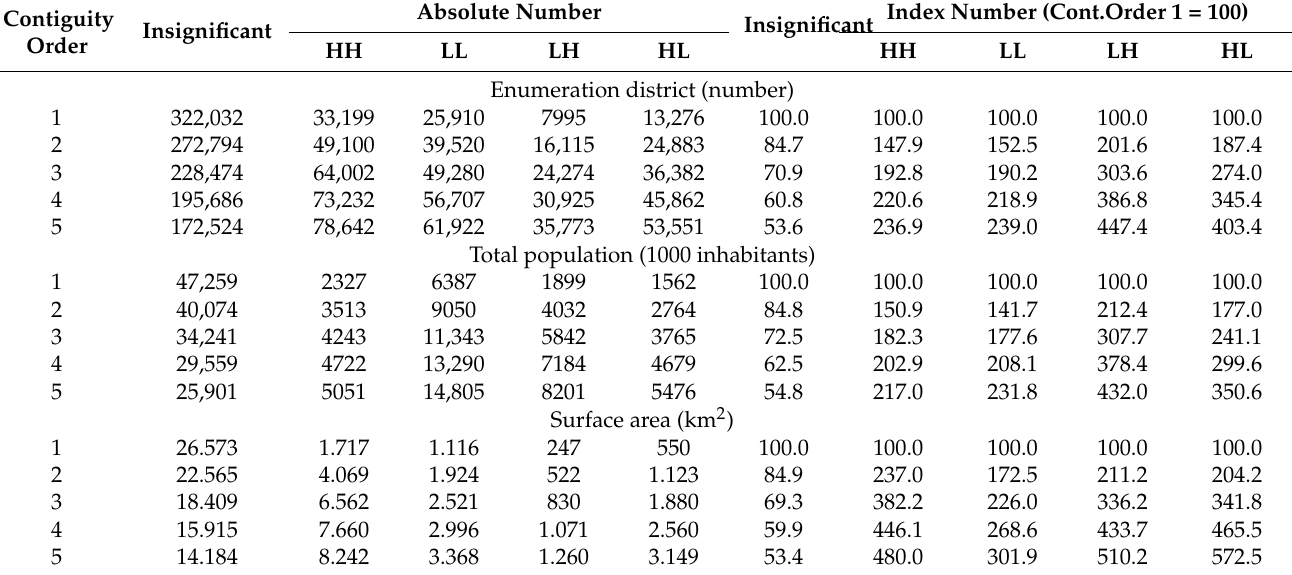
Table 3. The number of enumeration districts, total population, and surface area therein, by spatial clustering and contiguity